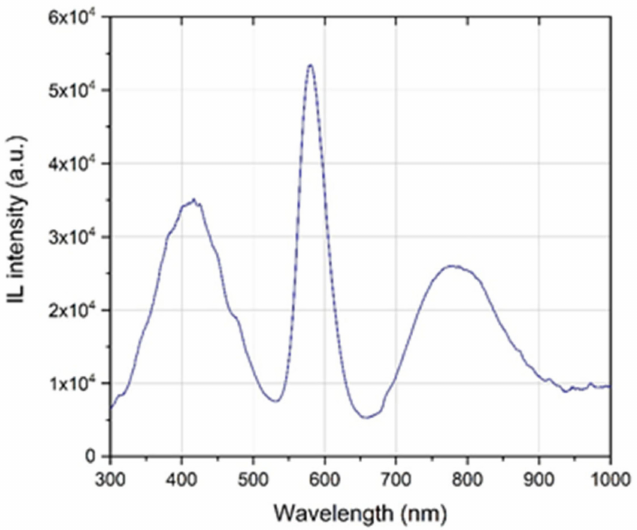
Figure 12. IL spectrum of a diopside crystal contained in lapis lazuli, acquired at the Legnaro National Laboratories of INFN with an Ocean Optics QEPro thermoelectrically cooled